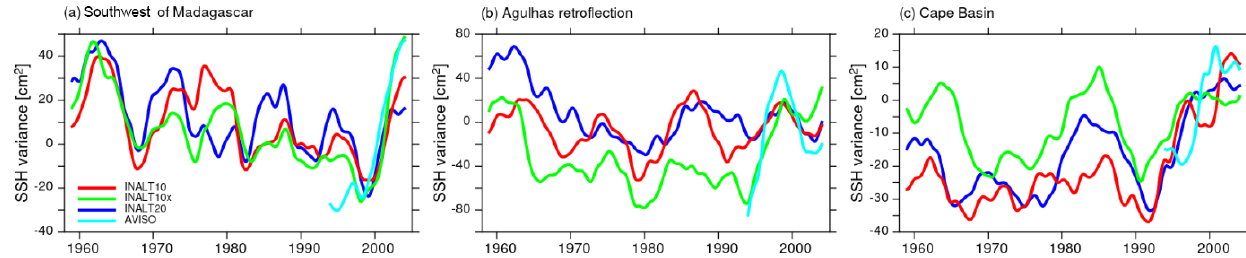
Figure 5. Time series of SSH variance anomalies to the 1995–2005 mean (in cm 2 ) computed in a 5-year running window based on 5d averages for the three different regions indicated in Fig. 3f from the nested configurations – INALT20 (blue) INALT10 (red) and INALT10x (green) – and from AVISO satellite altimetry (light blue). The curves are interannually filtered. For mean values and correlations, see Tables 4 and 5, respectively.